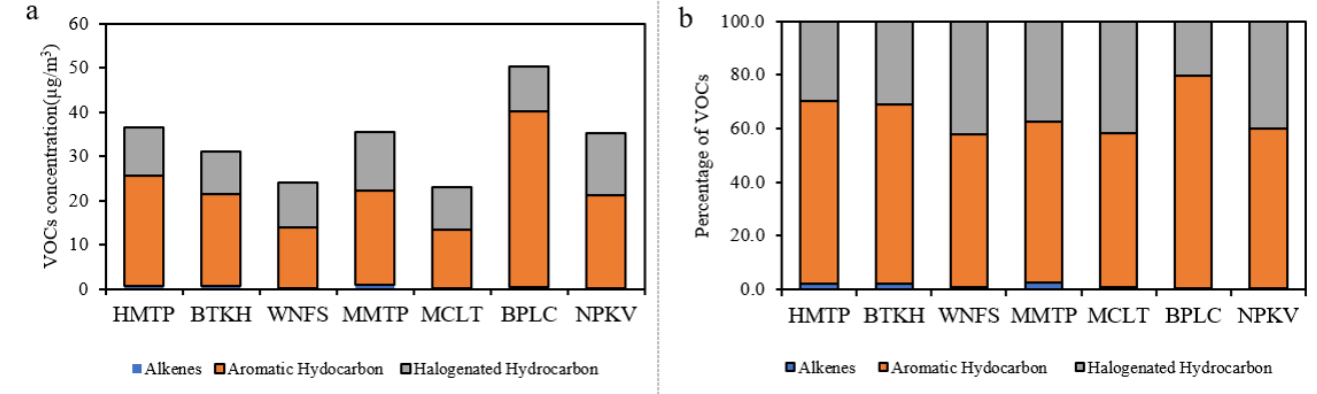
Figure 2. Concentration ( a ) and contribution ( b ) of three VOCs categories in the community areas. Within the industrial areas, the measured 20 VOCs species were classified in five categories: alkenes, aromatic hydrocarbons, halogenated hydrocarbons, aldehydes, and others. The VOCs concentration were dominated by halogenated hydrocarbons, with concentration of 6.0–40.9 µ g/m 3 , accounting for 25.0–73.9% of total VOCs. Aldehydes were the second largest group, ranging from 5.2–11.2 µ g/m 3 (11.6–45.1%), followed by alkenes (1.7–22.1 µ g/m 3 ; 3.1–41.8%), aromatic hydrocarbons (2.0–10.0 µ g/m 3 ; 4.1–24.3%), and others (1.0–4.0 µ g/m 3 ; 2.5–7.2%). The station with the highest VOCs concentration was MIEO (55.9 µ g/m 3 ), followed by I-2 (52.8 µ g/m 3 ), I-3 (49.8 µ g/m 3 ), I-4 (41.1 µ g/m 3 ), I-7 (24.8 µ g/m 3 ), E-IE (19.6 µ g/m 3 ), and I-1 (17.9 µ g/m 3 ). High concentrations of 1,3-butadiene